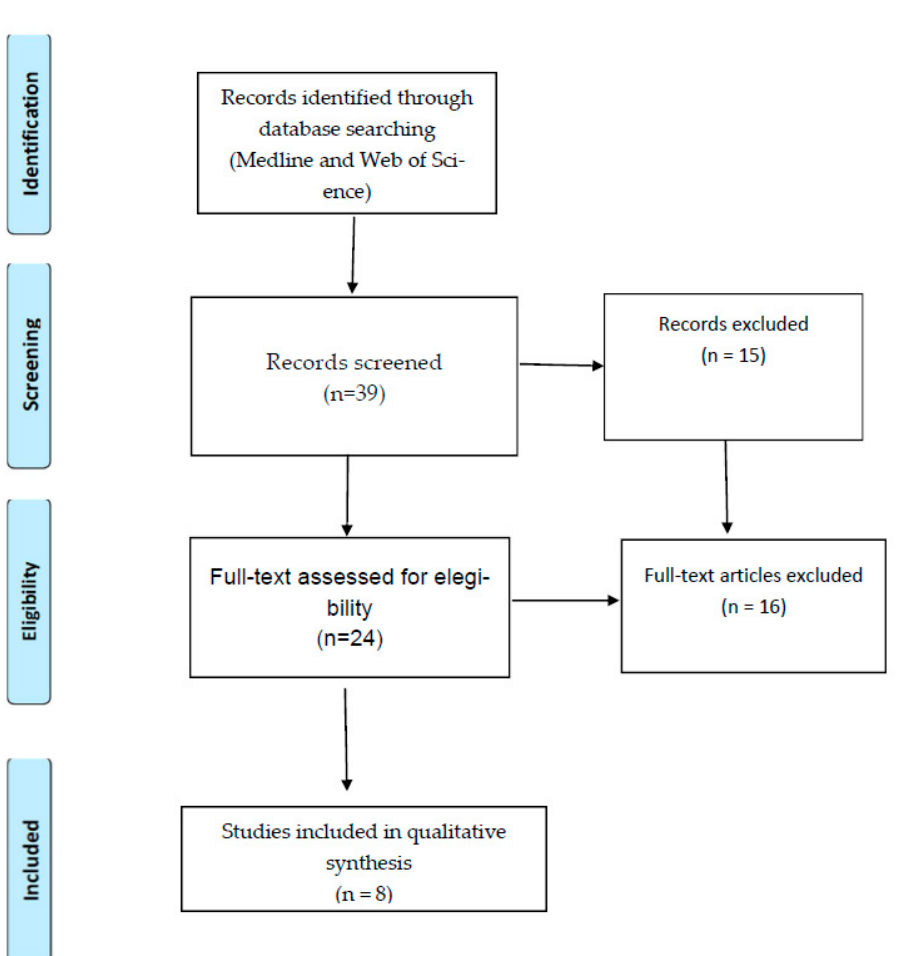
Figure 1. Identification, screening, and inclusion of studies for the review according to